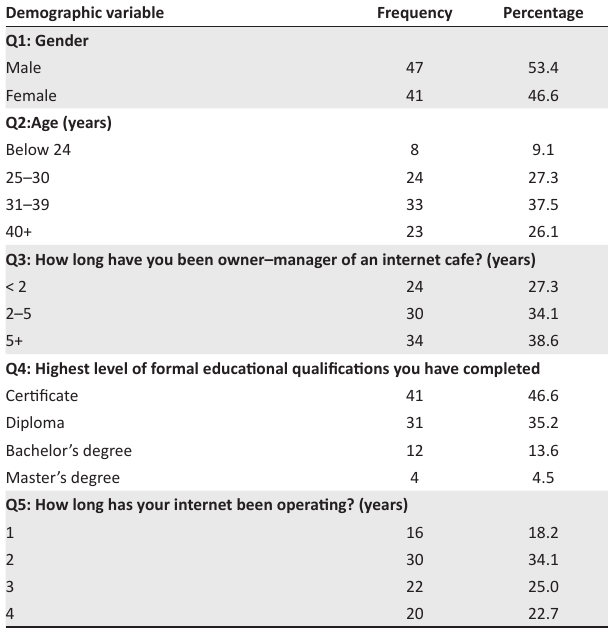
TABLE 1: Sample statistics of the